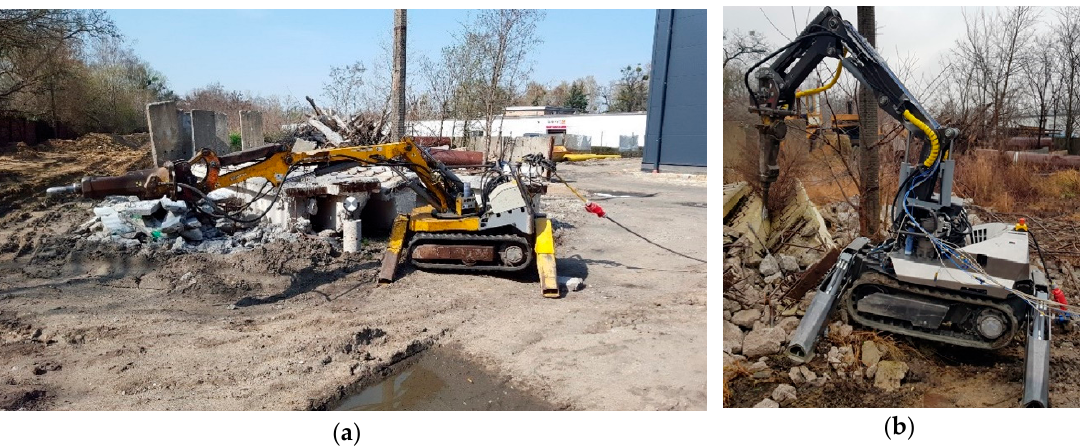
Figure 8. Experimental testing of remote-controlled demolition robots in a real-life application: ( a ) working arm positioned at its furthest point in front; ( b ) demolition of a concrete structure.